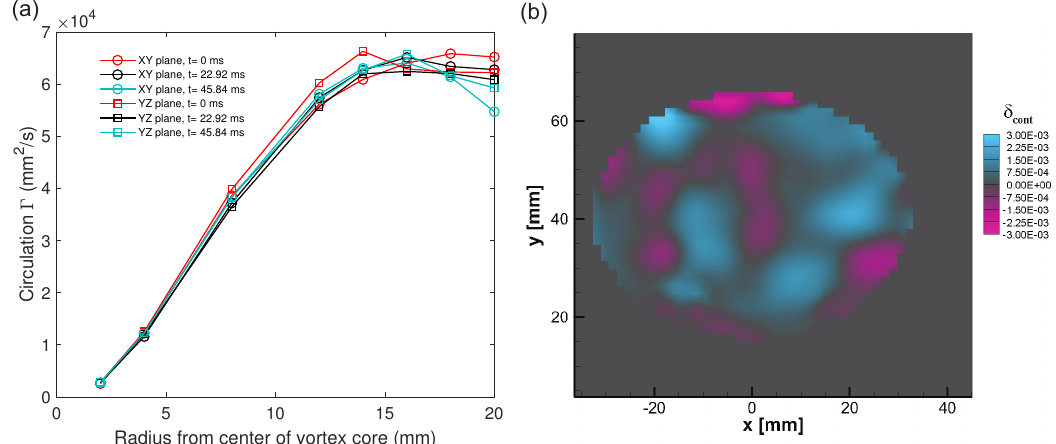
Figure 7. ( a ) Circulation, Γ , versus radius from the vortex core; data is presented for 2D cuts of planes xy and yz (the latter one is not visible to the central cameras) colored by the three different instants t = 0 (red), 22.92 (black) and 45.84 (blue) ms. The Reynolds number for this vortex ring is Re (cid:39) 16,500. ( b ) Contour plot of the normalized residual δ cont obtained from the continuity equation ∇ · u = 0 at the XY central plane ( z = 0) of the vortex ring at t = 43.75